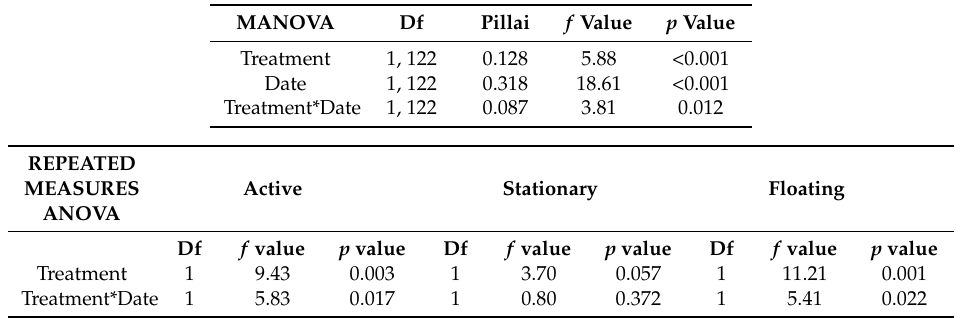
Table 1. MANOVA table reporting the results of a multivariate comparison evaluating differences in